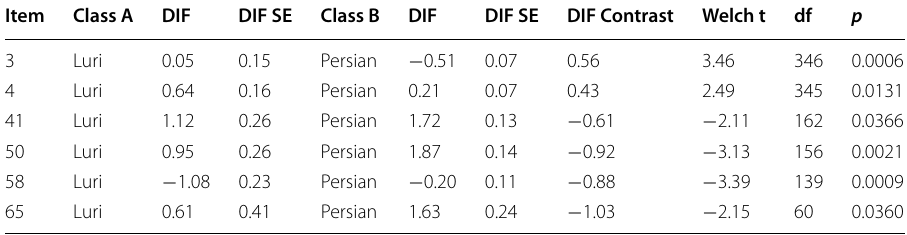
Table 11 Results of uniform DIF analysis of items (IUUESEE